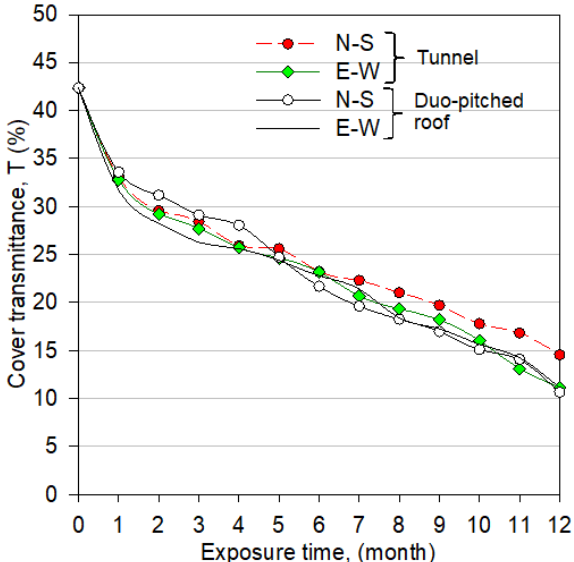
Figure 7. Average transmittance of the cover envelops ( T ), estimated for each prototype during the time of exposure to arid climatic agents.